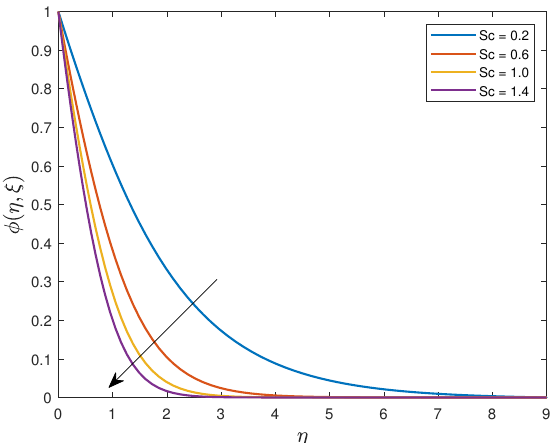
Figure 12. The influence of Sc on fluid concentration.